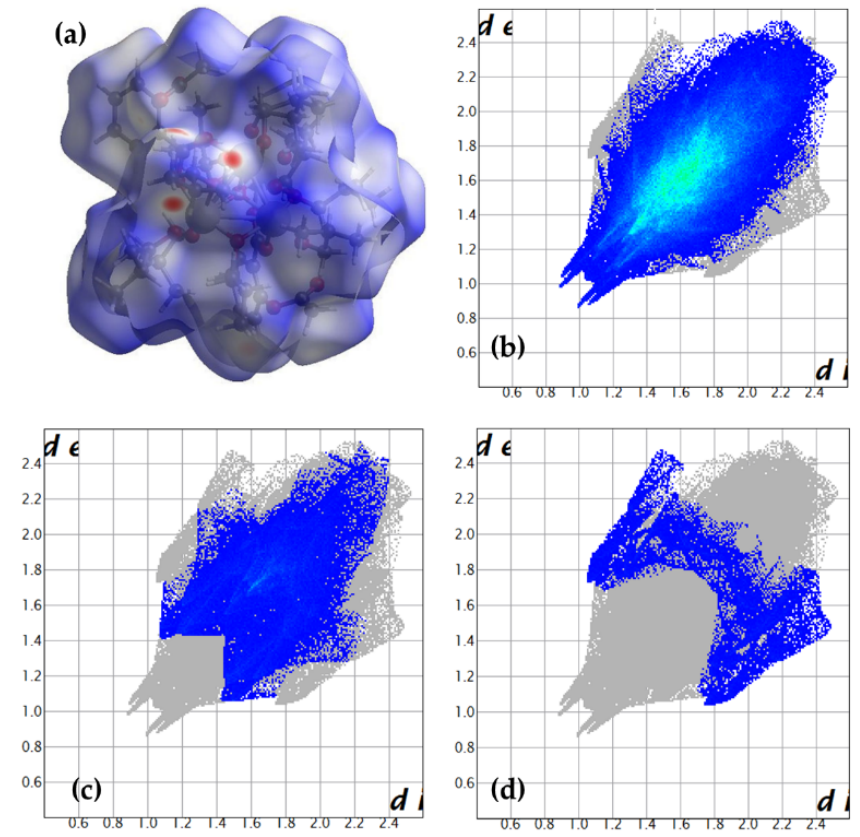
Figure 1. ( a ) Ti 4 O 2 core of [Ti 4 O 2 (asp) 2 (Bu i O) 10 ]·H 2 O ( 1 ) with labeled titanium and oxygen atoms. For clarity of the picture, all hydrogen atoms and the most of carbon atoms are omitted. Oxygen atoms from oxo bridges are given in yellow, from carboxylate anions in orange, from Bu i O − anions in red. ( b ) Positions of water molecules oxygen atoms (yellow and circled) presented in the crystal lattice of ( 1 ).